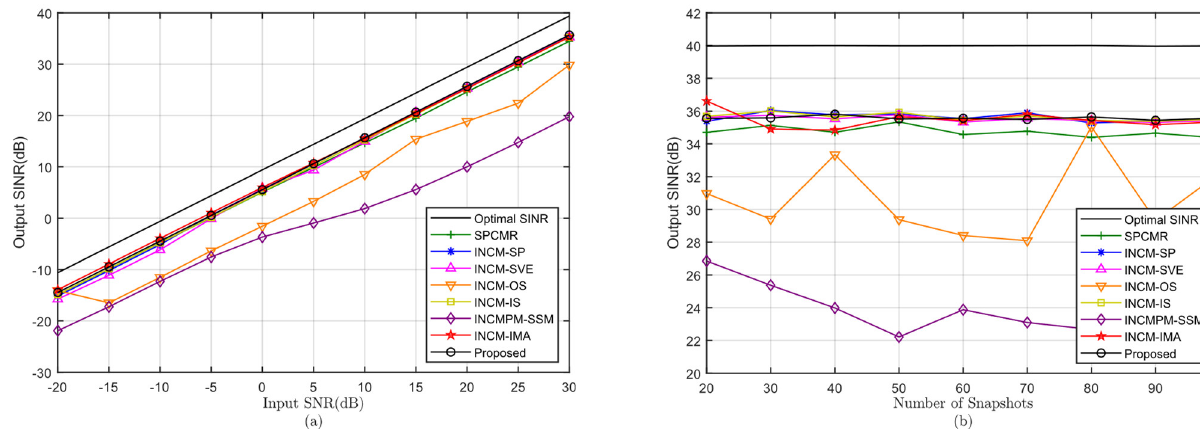
Figure - 4. Example 3: output SINR vs.: ( a ) input SNR; ( b ) number of snapshots. Figure 4. Example 3: output SINR vs.: ( a ) input SNR; ( b ) number of